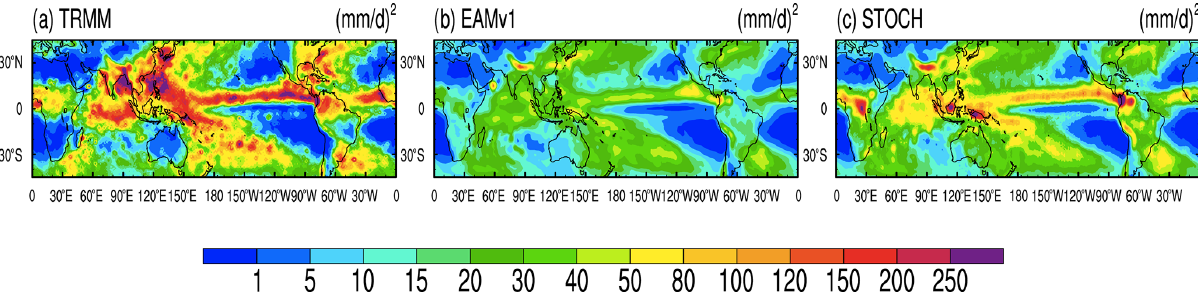
Figure 2. Spatial distributions of the synoptic variance of rainfall from (a) TRMM, (b) EAMv1 and (c) STOCH (units: mm 2 d − 2 ).